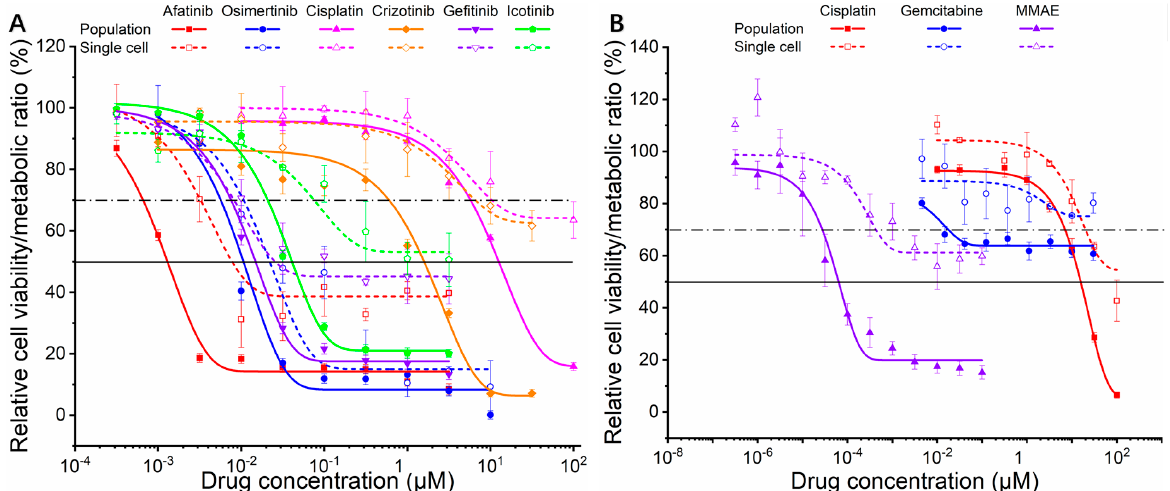
Figure 5. Dose–effect curve of relative cell viability obtained at the bulk level and metabolic ratio obtained at the single-cell level for HCC827 ( A ) and MCF-7 ( B ) toward different chemotherapy drugs. Colored solid curves represent the dose–effect curves at the population level. Colored dashed curves represent the dose-effect curves at the single-cell level. The horizontal solid lines and dotted-dashed lines indicate the level of 50% of relative cell viability and 70% of metabolic ratio, respectively. Error bars represent the standard deviation among the